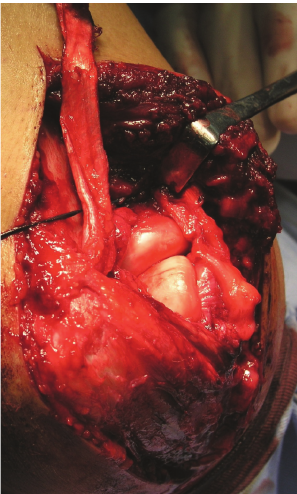
Figure 2: Fascia flap of triceps of 7mm width and 100mm long was made, which was passed from posterior to anterior around the head of radius.